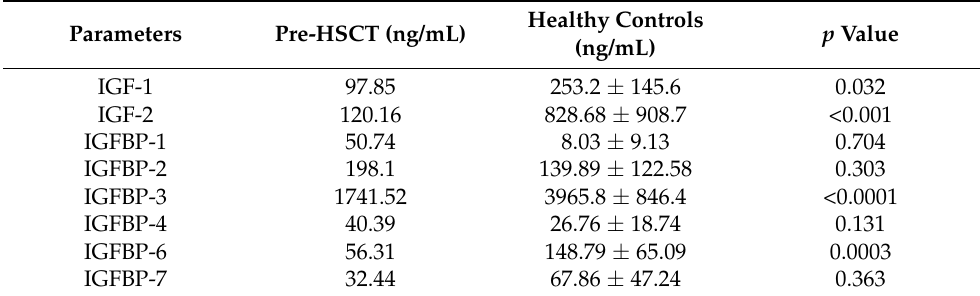
Table 5. Concentrations of IGFs and IGFBPs in pre-HSCT group and healthy controls.